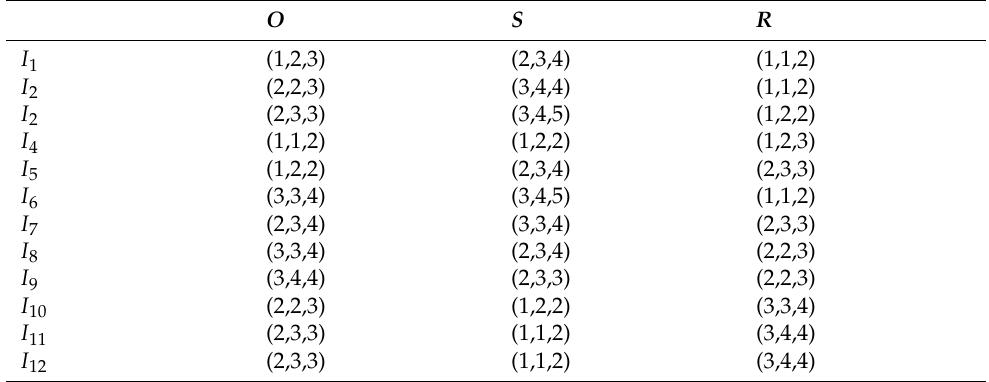
Table 7. Expert E 1 ’s evaluation